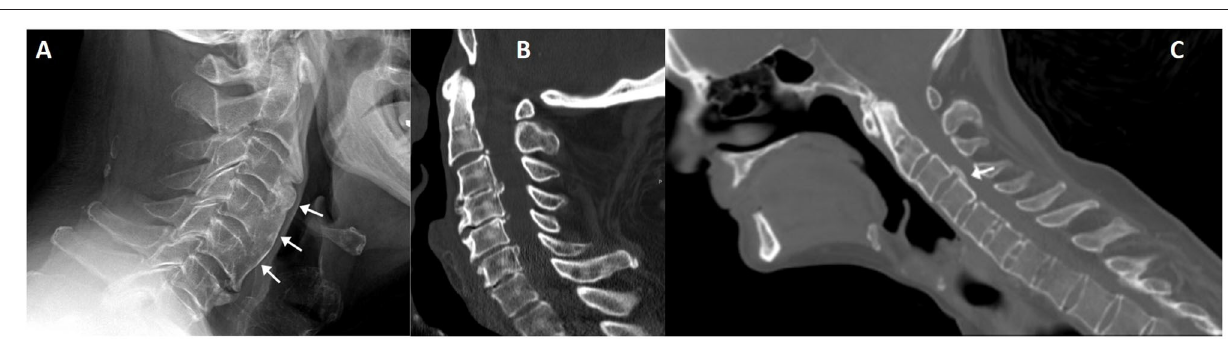
wavy calcifications are found where ligaments, tendons and capsules attach to